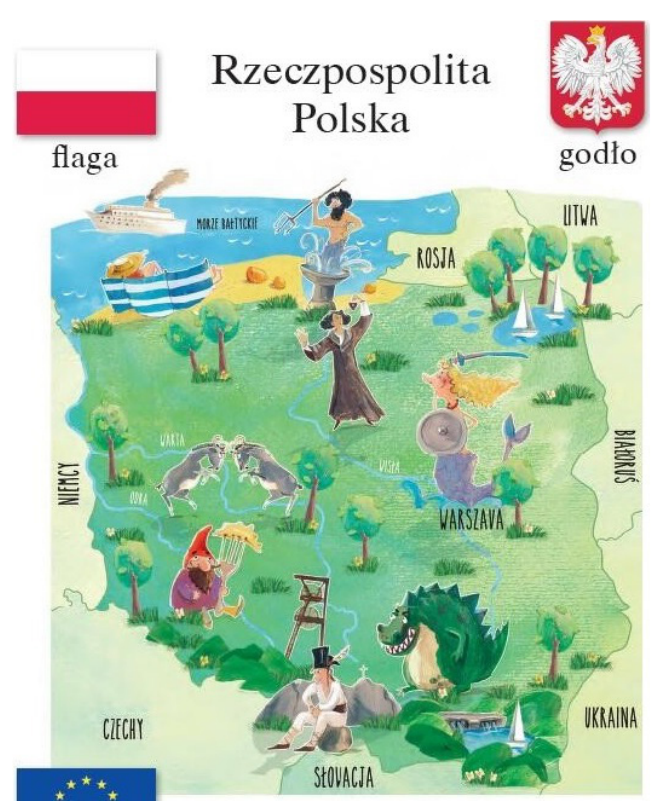
Fig. 2. The original version of the map of the Republic of Poland from Nasz elementarz (reduced, source: